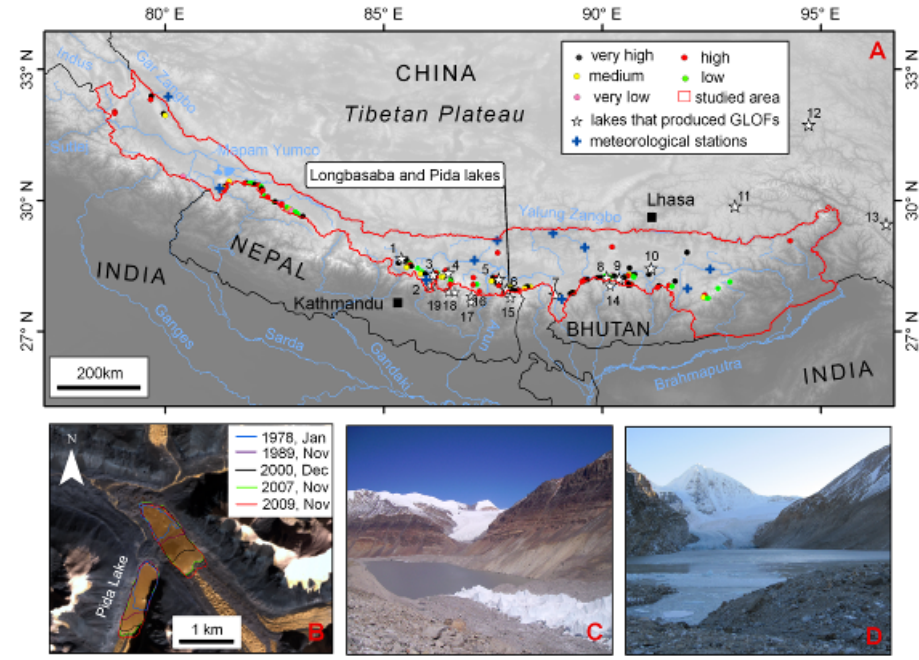
Figure 1. (A) Distribution of different outburst probability statuses of PDMDLs in the Himalayas of China (stars indicate the MDLOF lakes in Table 2 and the identification numbers are those used in the table). (B) Expansion of two field-surveyed PDMDLs, Longbasaba and Pida Lakes, based on aerial photographs (1978), Landsat TM data (1989, 2000, and 2009), ASTER data (2007) and field survey data (2009). (C) Photograph of Longbasaba Lake taken in October 2009. (D) Photograph of Pida Lake taken in October 2009.